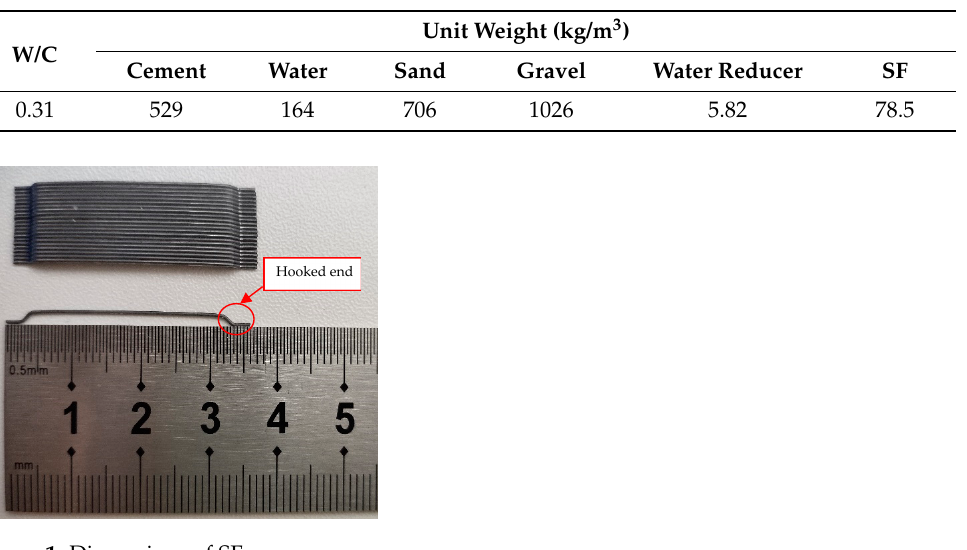
Figure 2. BFRP bars. Table 3. Mechanical properties of reinforcing bars. Bar Type Diameter (mm)